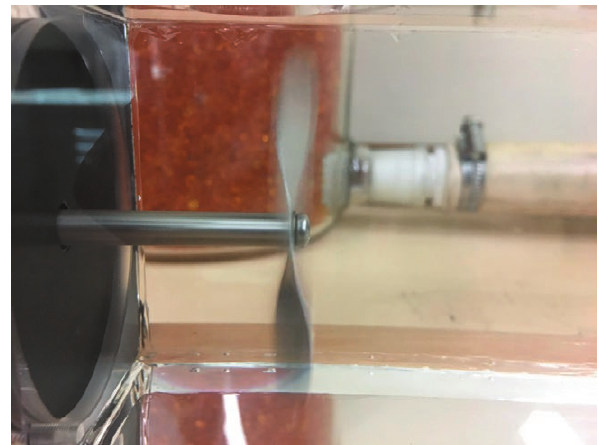
Figure 8. Complete cavitation prevention after gassed water was replaced with 70% de-gassed tap water (at 2960 rpm